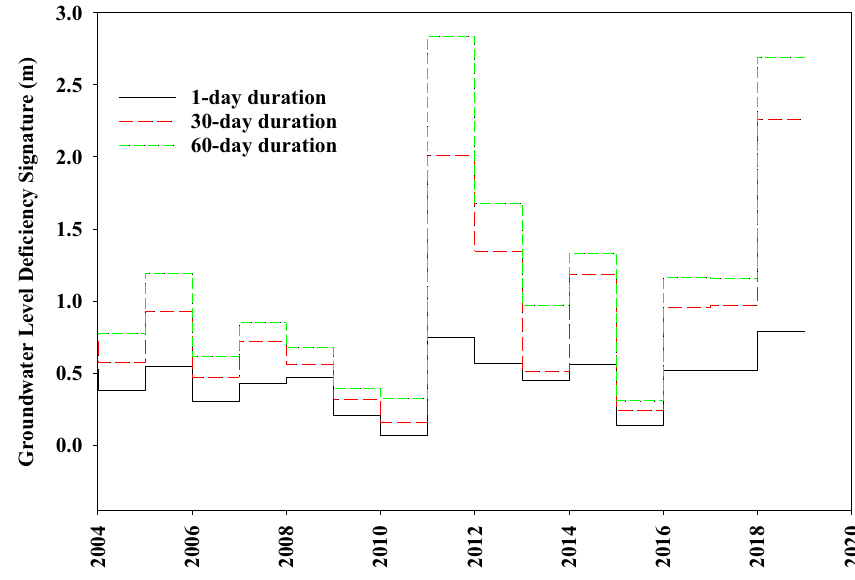
Fig. 6 Results of groundwater level deficiency signature in Nazloo piezometric well for 10, 30 and 60-day durations in statistical period of